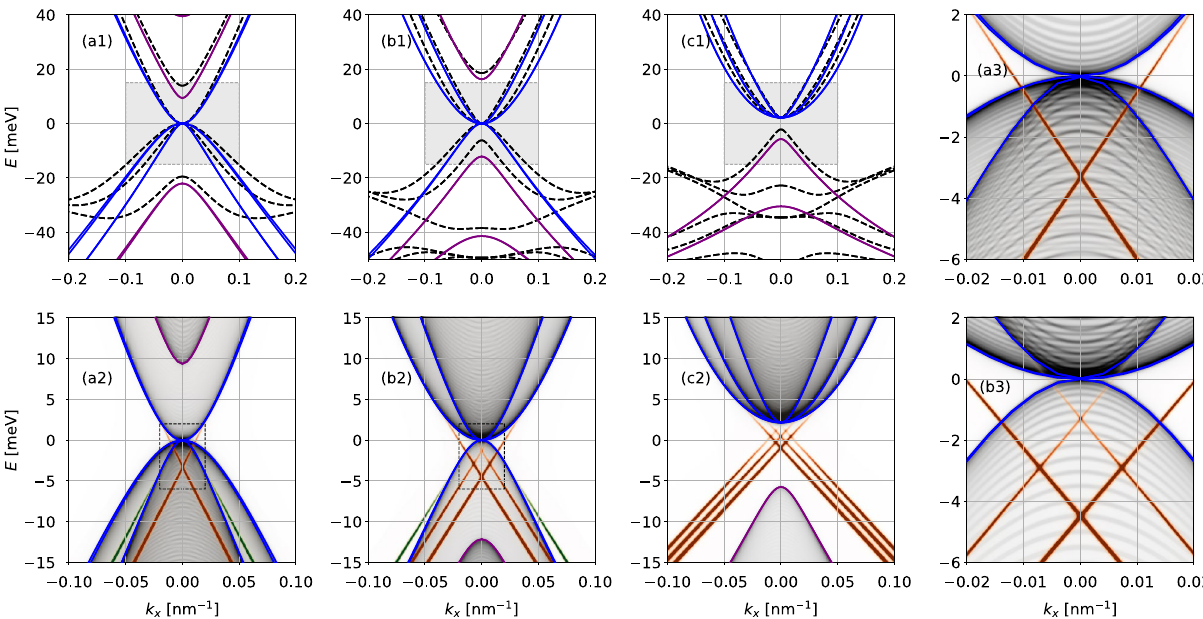
8 Kane model (black Figure 3. ( a1 , b1 , c1 ) Comparison of the bulk band structures calculated with the 8 × dashed lines) and the effective 2D 3 BHZ model (solid lines) with E-like subbands in purple and H-like × subbands in blue. The panels correspond to the phases I, II and III indicated by the cyan stars in Fig. 2b. 1000 nm shown by the local density of ( a2 , b2 , c2 ) Band structures for a nanoribbon geometry of width L y = states of the bulk (gray tones) and edges (orange and green tones). The E - k range match the shaded regions from the panels above. The 3 BHZ bulk subbands are shown as the solid lines as a guide to the eyes. ( a2 ) For × 6 nm the topological regime with one E-subband below the H subbands shows one pair of topological edge d 0 = state (orange) and two pairs of trivial edge states (green). ( b2 ) As a second E-subband crosses the H subbands 7 nm one gets two topological edge states a single trivial edge state. ( c2 ) For d 8.5 nm the system for d 0 = = reaches the full topological regime with three topological edge states and a well defined gap. ( a3 , b3 ) Zoom into the rectangles of ( a2 , b2 ) emphasizing the edge states. All of the subbands above are